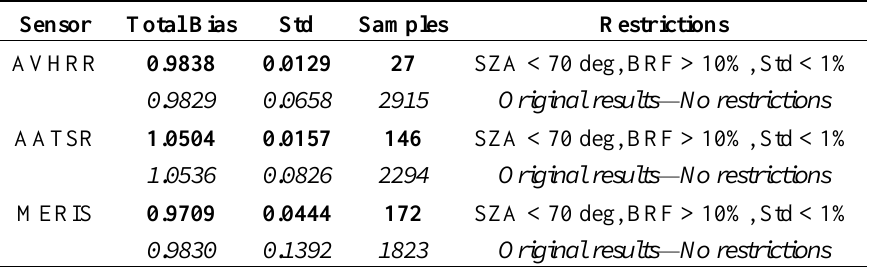
Table 2. Summary of results for all Simultaneous Nadir Observation (SNO) match-up targets for the Advanced Very High Resolution Radiometer (AVHRR)-heritage channel at 0.6 µm based on inter-comparisons with Moderate Resolution Imaging Spectroradiometer (MODIS) on the AQUA satellite. The total bias is expressed as the relative bias ( i.e. , reflectance factor quota or radiance quota). Sensor Total Bias